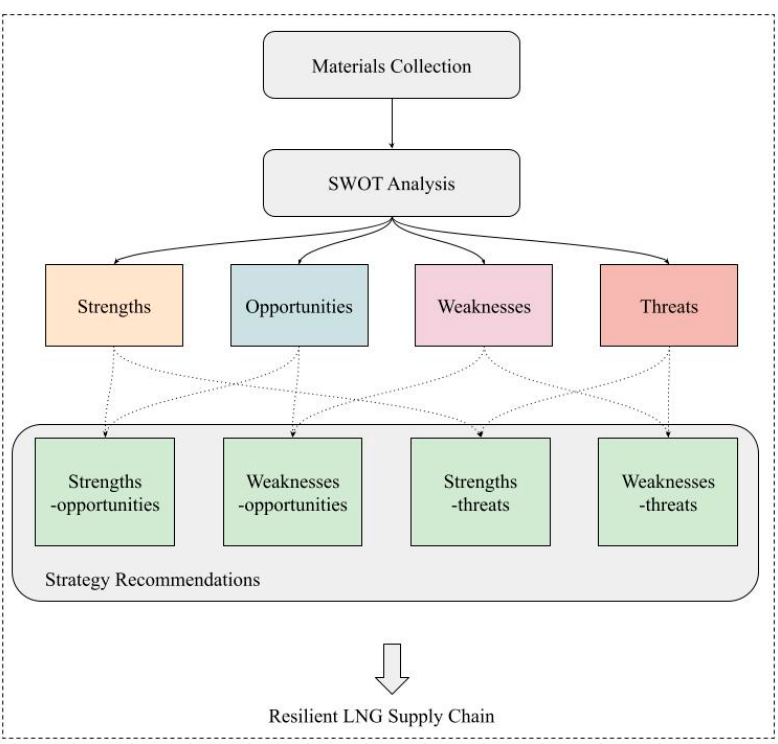
Figure 1. A flowchart of the applied methodology for the LNG supply chain via a SWOT analysis (Source: Compiled by the authors from